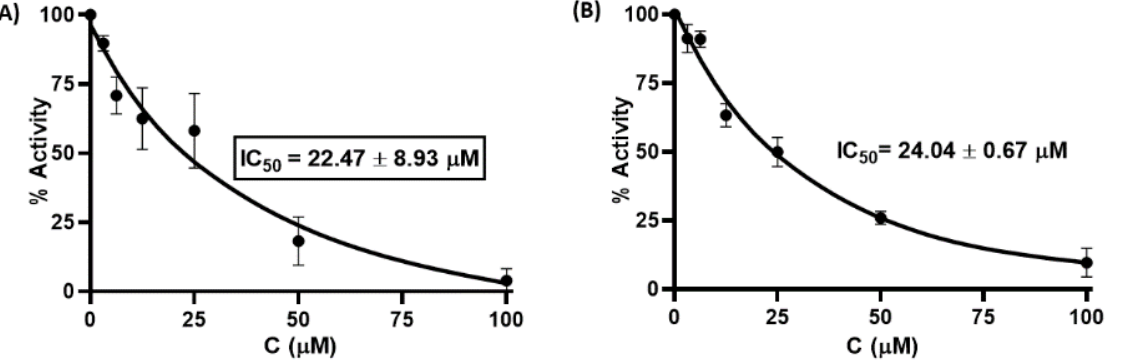
Figure 3. Inhibitory activity of serial dilutions of G1 ( A ) and G4 ( B ) against SARS-CoV-2 M pro